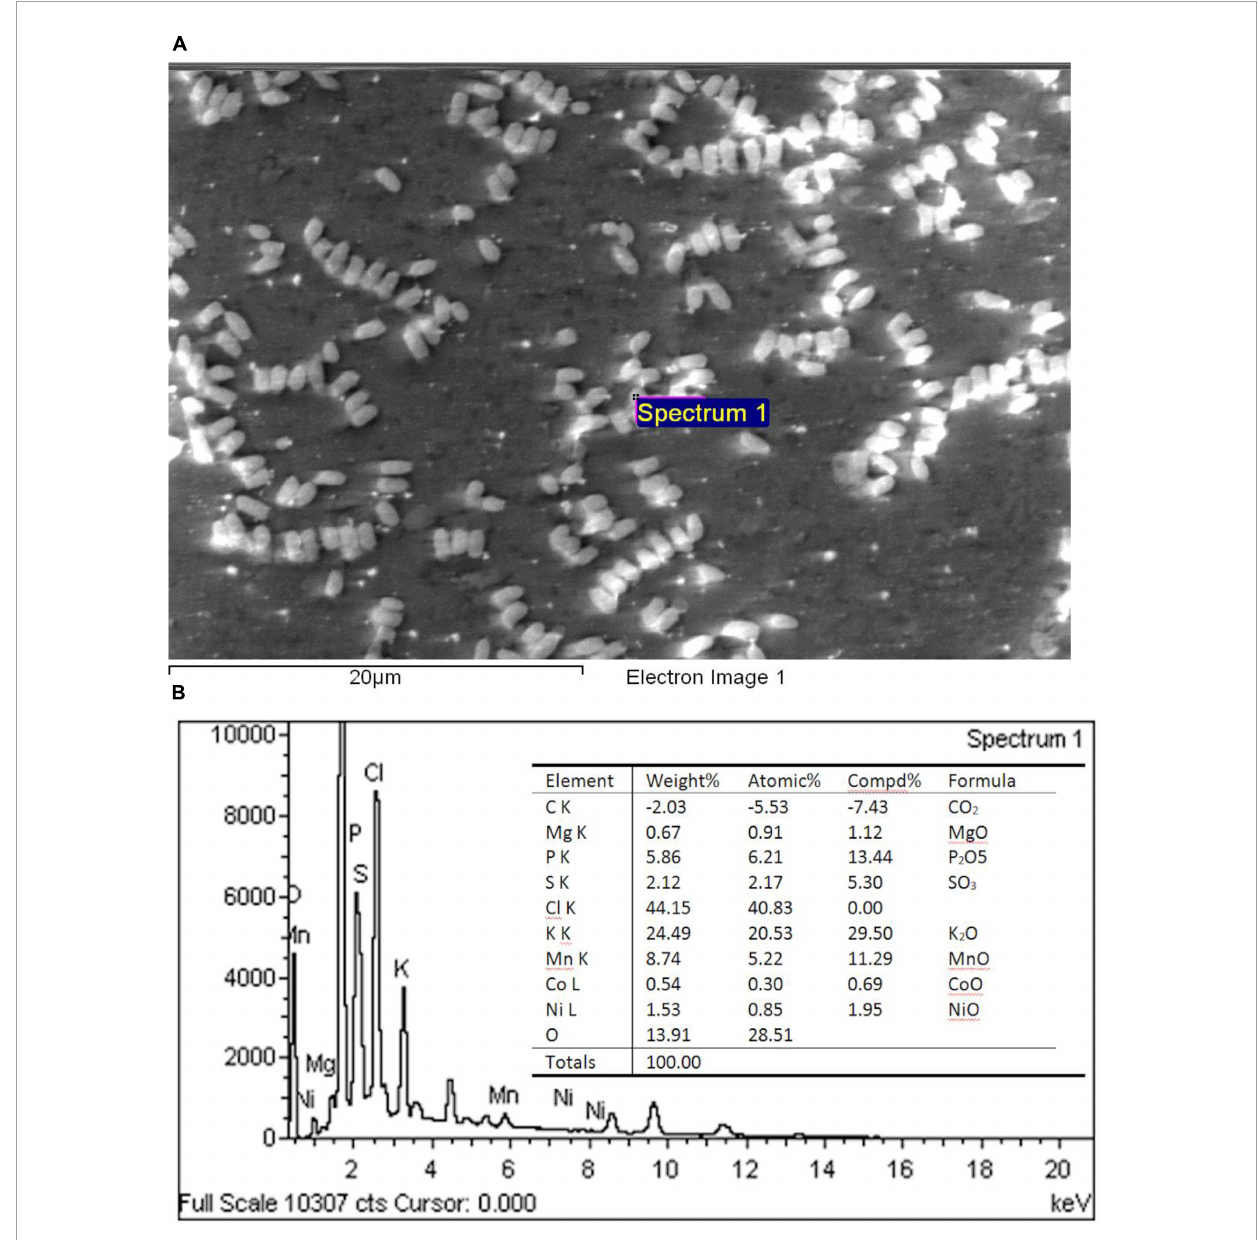
FIGURE6 (A) SEM–photomicrograph of Chromohalobacter sp. when grown with 1 mM Mn and (B) energy dispersive X-ray spectrometric analysis of the manganese oxide produced by Chromohalobacter sp. when grown with 1 mM Mn.